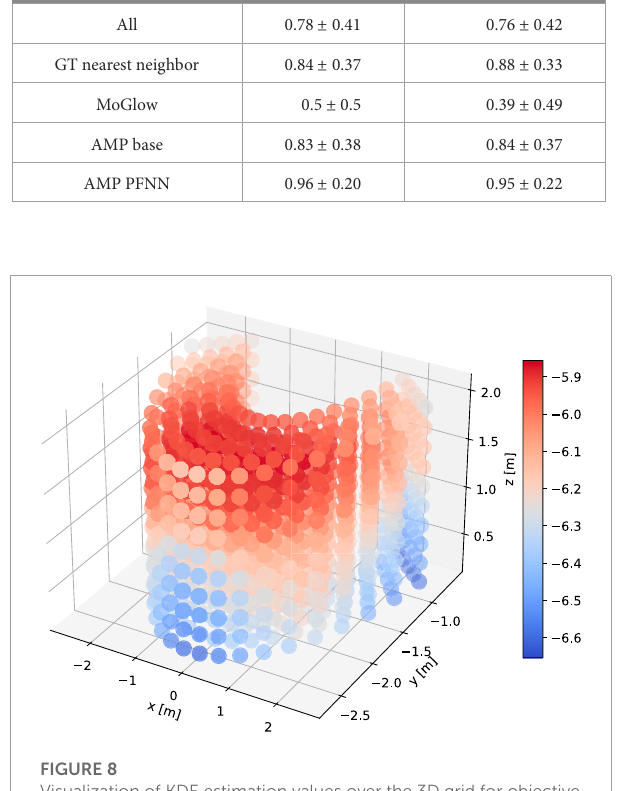
FIGURE 8 Visualization of KDE estimation values over the 3D grid for objective evaluation. The KDE was fitted on the training set targets.